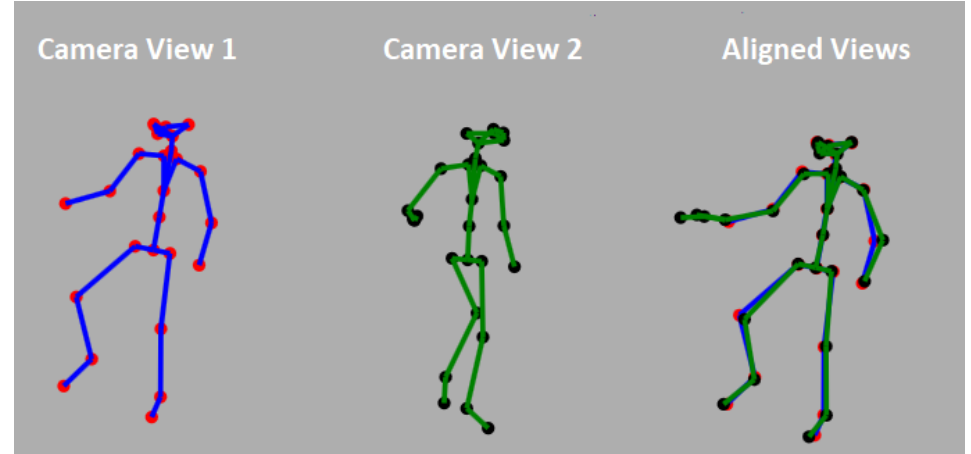
Figure 6. Skeleton alignment for two cameras positioned 180 degrees from each